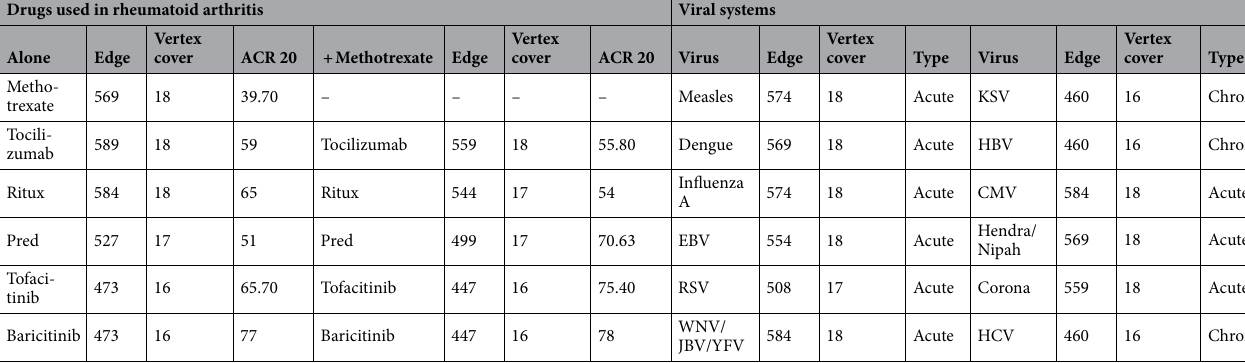
Table 1. Effect of different drugs and viral evasion mechanisms on the network size of the human Janus Kinase/Signal Transducers and Activators of Transcription (JAK/STAT) pathway. ACR 20 responses are expressed as percentages. ACR 20: American College of Rheumatology 20 response; CBV: cytomegalovirus; EBV: Epstein Barr virus; HBV: hepatitis B virus; HCV: hepatitis C virus; JBV: Japanese B virus; KSV: